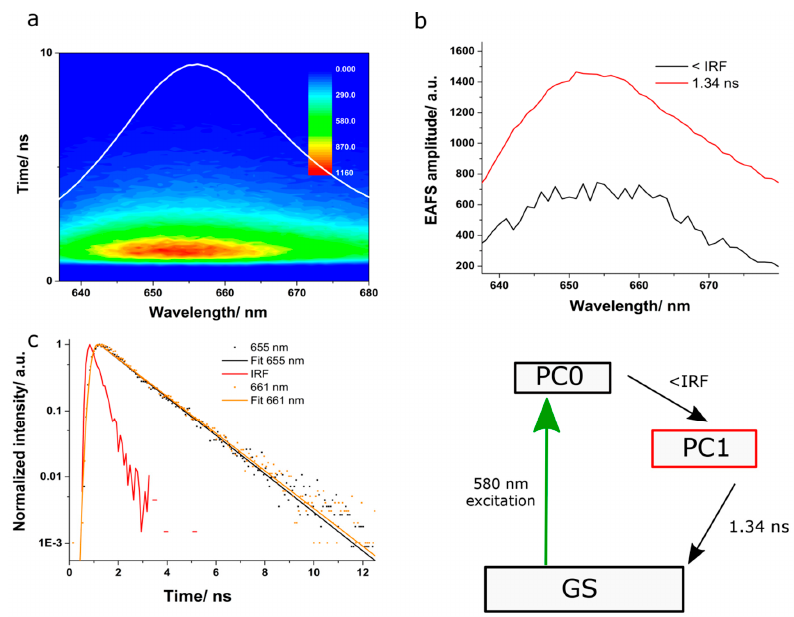
Figure 3. ( a ) Time-correlated single photon counting (TCSPC) data showing the three-dimensional data carpet obtained from phycocyanin (PC) when pumped at 580 nm. The white line represents the steady-state fluorescence spectrum; ( b ) Evolution- associated fluorescence spectra obtained using global analysis according to the scheme given in the bottom right figure corner; ( c ) Normalized kinetic traces recorded at 655 and 661nm with fits.